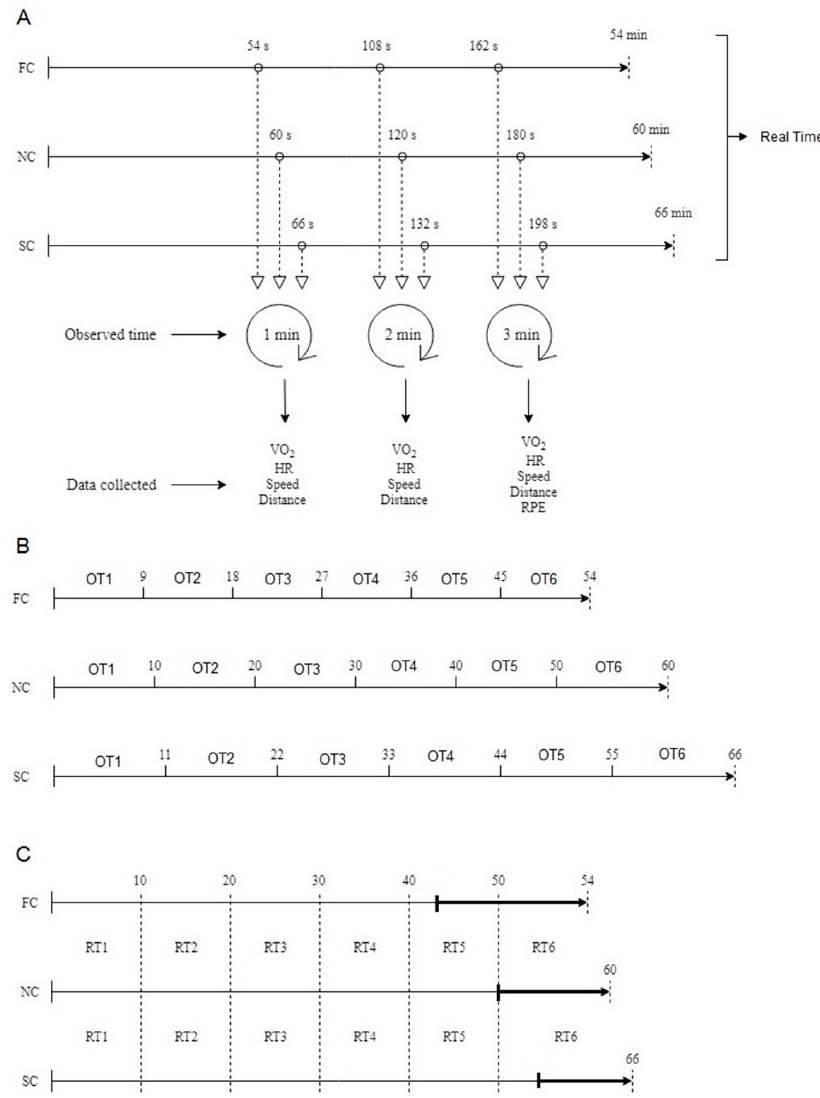
Figure 1. Representation of the first 3 min of each test ( A ), of the observed time ( B ), and of the real time ( C ) analyses. The bold arrows in 1C indicate the last 10 min of each condition. ( A ) Description of the real time, the time observed by the participants at the real time, and when data were collected for the first 3 min in each chronometer condition (Faster Chronometer—FC, Normal Chronometer—NC, and Slower Chronometer—SC). This pattern continues until the end of each test. HR = Heart Rate, VO2 = Oxygen Consumption, RPE = Rate of Perceived Exertion. ( B ) With respect to the real time, data were collected every 9 min in the FC, every 10 min in the NC, and every 11 min in the SC (OT1, OT2, OT3, OT4, OT5, OT6). ( C ) Data collected in every 10-min period of the real time (RT1, RT2, RT3, RT4, RT5) and in the final time period for each chronometer condition (RT6: FC = 4 min, NC = 10 min, and SC = 16 min). The thicker arrow in each condition indicates the last 10 min of the real time (i.e.,